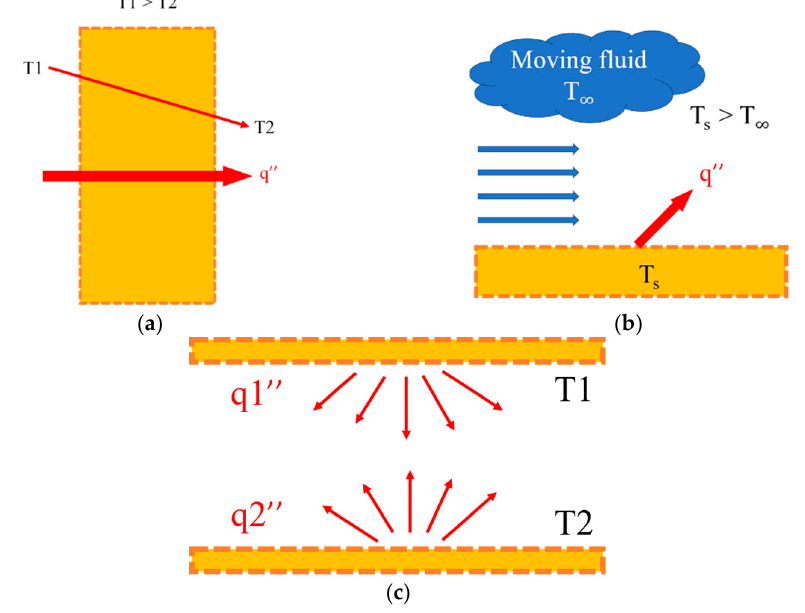
Figure 1. Heat transfer. ( a ) Heat conduction. ( b ) Heat convection. ( c ) Heat radiation.